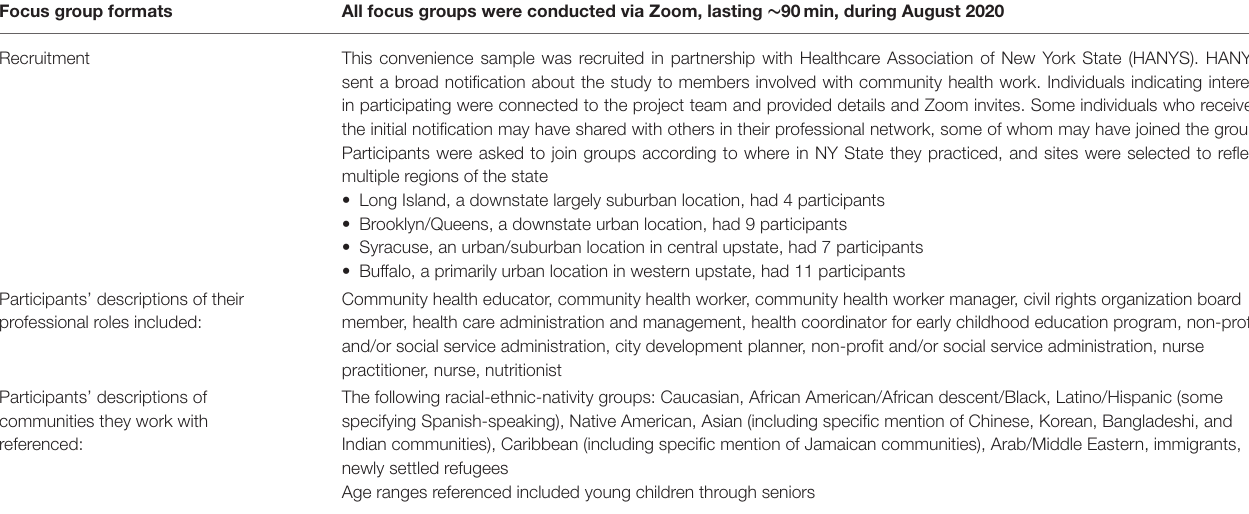
TABLE 1 | Focus group format, recruitment, and participants. Focus group